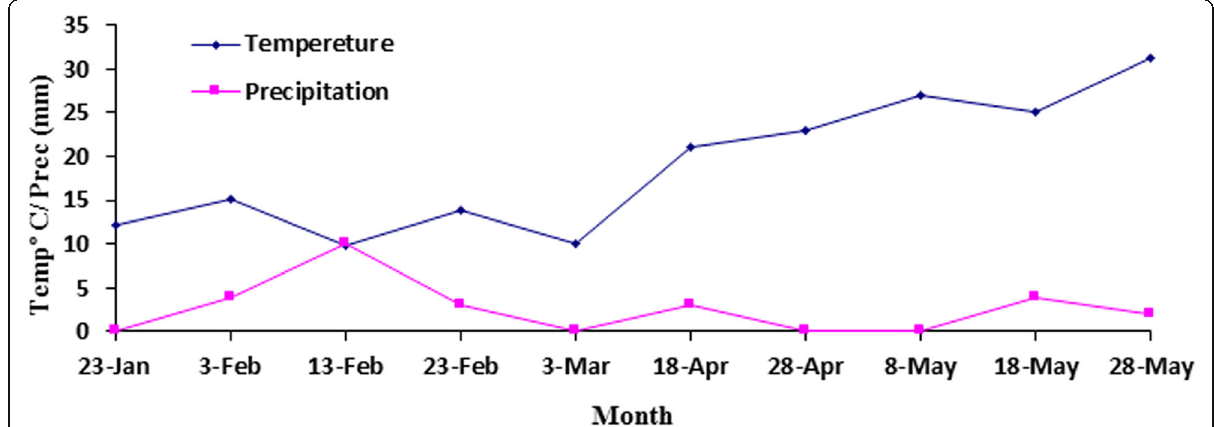
Fig. 1 Temperature and precipitation recorded during the spring and winter studies of insect occurrence on rabbit carcasses in